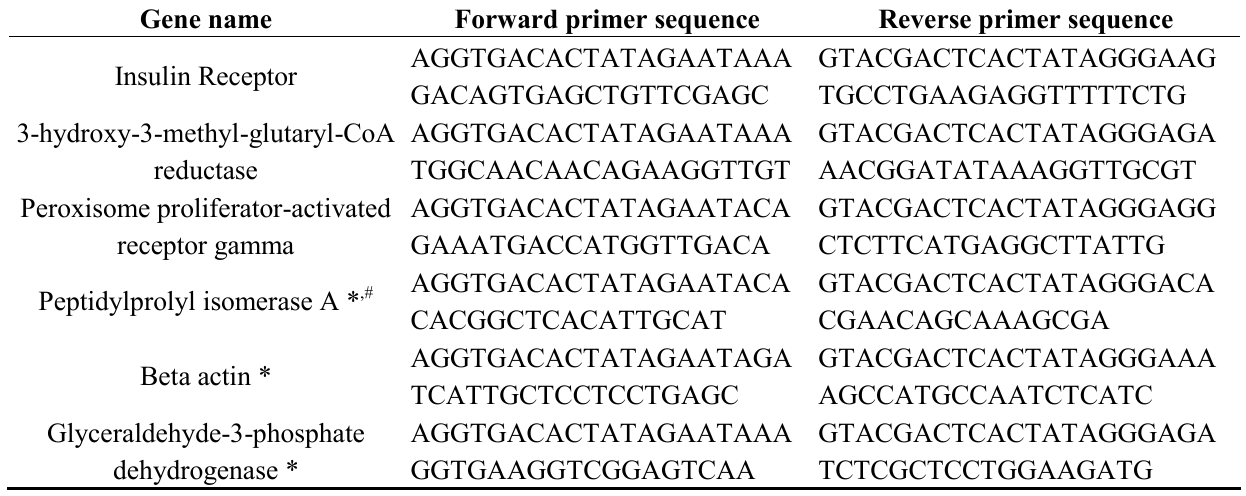
Table 1. Gene name and sequences of primers used in multiplex